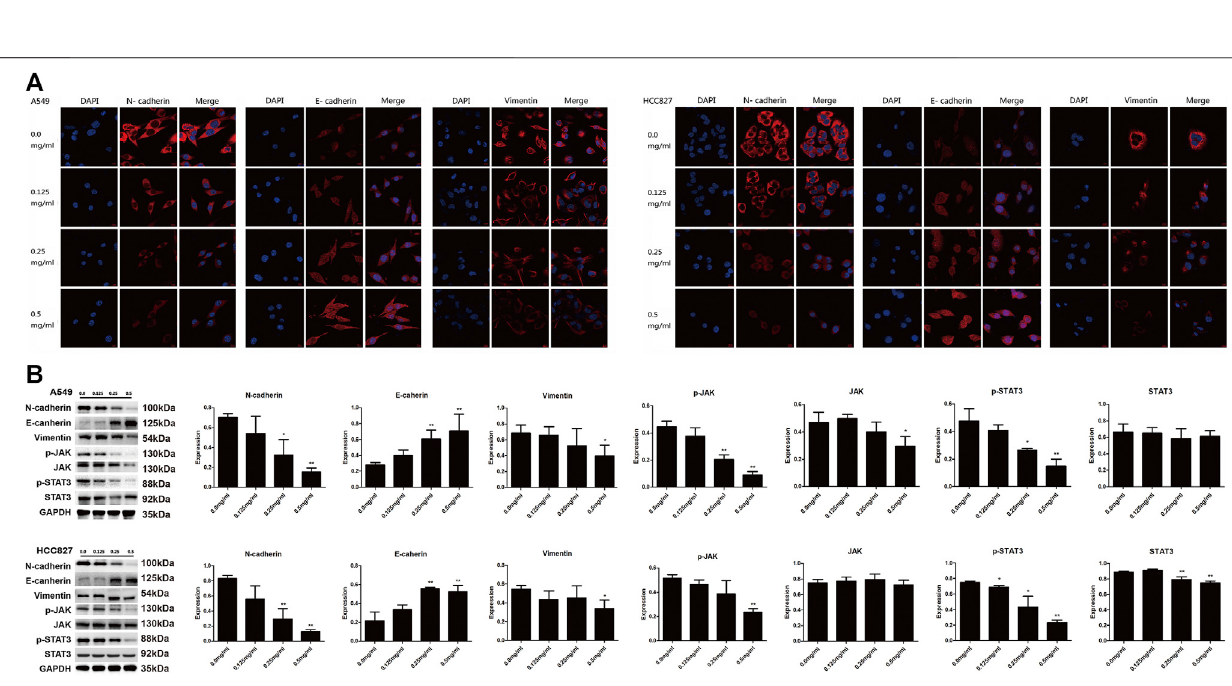
FIGURE 5 | AETW suppressed the migration and invasion of LC cells with increasing concentrations and exposure time. (A) Detections of cell migration by the wound healing assay and their quantitative analyses. (B) Detections of cell invasion using transwellplates and their quantitative analyses. Compared with the fi rst group, * p < 0.05, ** p < 0.01.